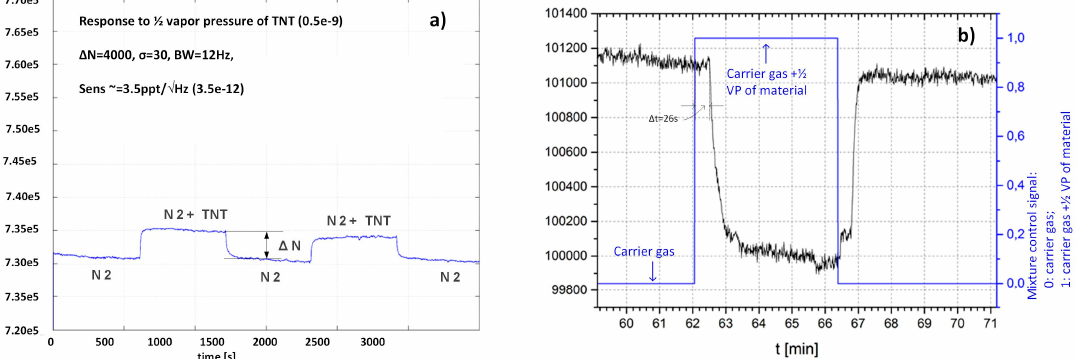
Figure 14. ( a ) Time response of the sensor functionalized with APhs to the TNT vapour at ½ vapour pressure of the TNT. ( b ) Time response of the sensor functionalized with UPS to H 2 O vapour at approx. vapour pressure. In both cases the response is without dimensions and corresponds to dC / C .